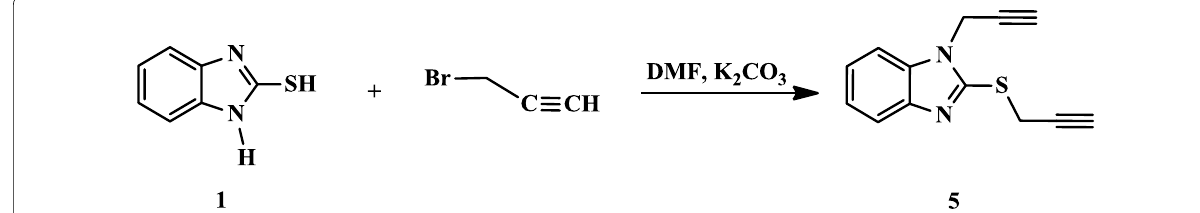
Scheme 3 Synthesis of S,N ‑Bispropargylated benzimidazole